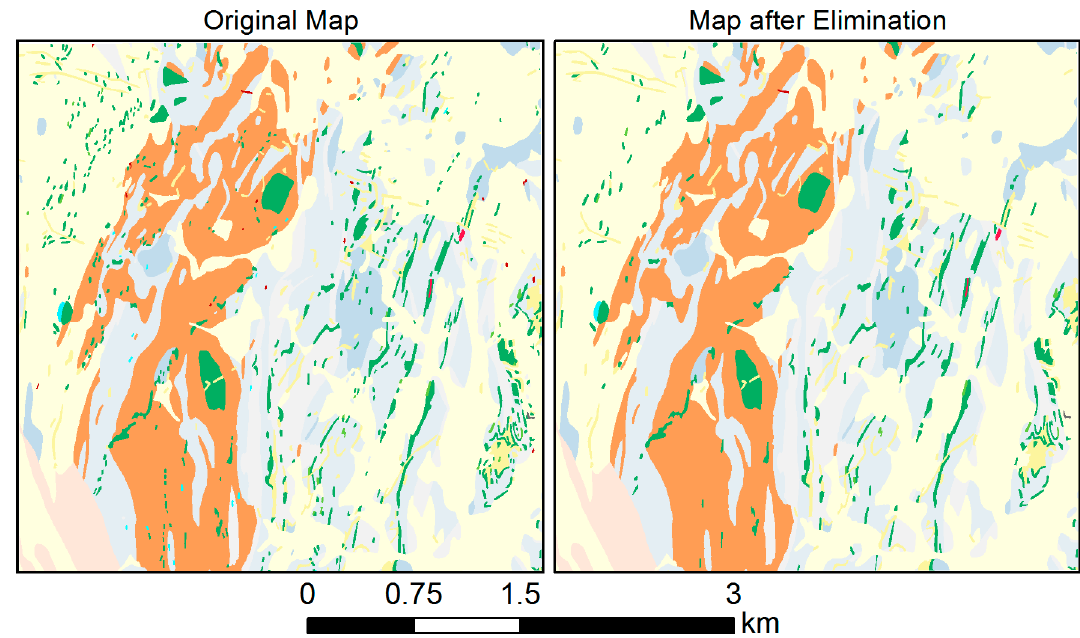
Figure 10. Part of the geological map of the Euriowie Block, NSW, Australia. The original map, left, was produced at the scale of 1:25,000, but is shown here at the scale of 1:50,000, as are all the maps in Figures 10–13. On the right, a map after elimination of less important polygons using the “Radical Law selection” approach is